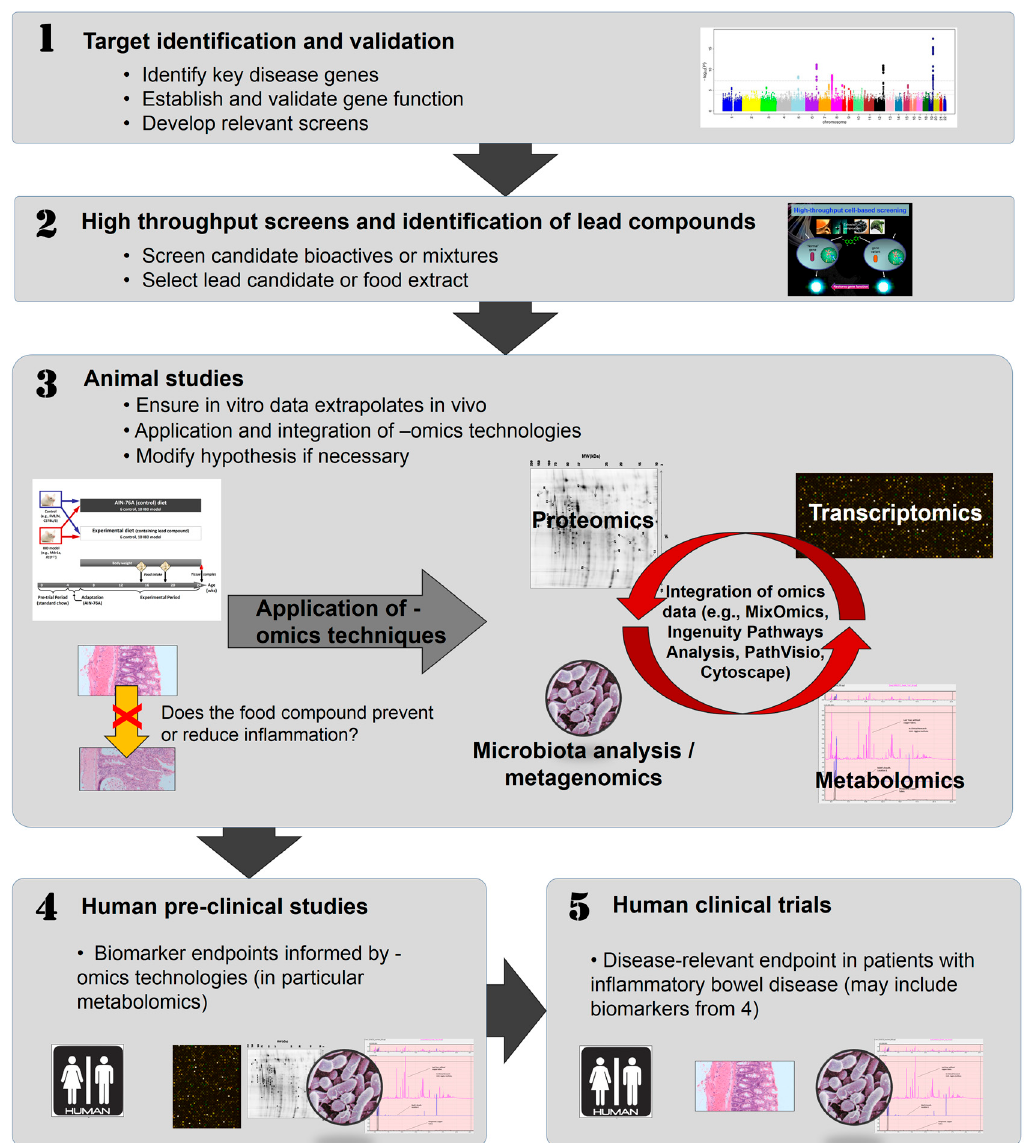
Figure 1. A potential sequence of in vitro to in vivo studies, including the application of omics technologies. This flow diagram shows a potential approach, working from in vitro through in vivo studies to human clinical trials, with the application of omics technologies at several stages. ( 1 ) There is increasing use of high-throughput techniques, such as single nucleotide polymorphism (SNP) chips, which enable genome-wide assessment to identify genetic factors which may be linked to a particular disease or health outcome. Relevant SNPs can then be incorporated into suitable in vitro assays ( 2 ) in which food compounds can be assessed for their abilities to interact with the SNP of interest and modulate its function. Effective food compounds can then be tested in appropriate animal models ( 3 ) which exhibit the relevant phenotype and/or have the SNP of interest (or one in a related gene). This can initially be used to establish if the food has an effect on phenotype and, subsequently a range of omics techniques can be applied, and data derived from them integrated, to better understand the mechanism by which a food may exert its effect. Food compounds which show efficacy both in vitro and in vivo may then be suitable as candidates for human studies, both pre-clinically (for example, to assess any possible biomarkers identified in the animal studies ( 4 )) and, finally, clinically, to ascertain a clinically-relevant end-point, such as an improvement of IBD-associated symptoms ( 5 ). The Manhattan plot shown in ( 1 ) was originally published by Ikram, M.K.; et al. [36] and was obtained from Wikipedia (https://commons.wikimedia.org/wiki/File:Manhattan_Plot.png). This image file is licensed under the